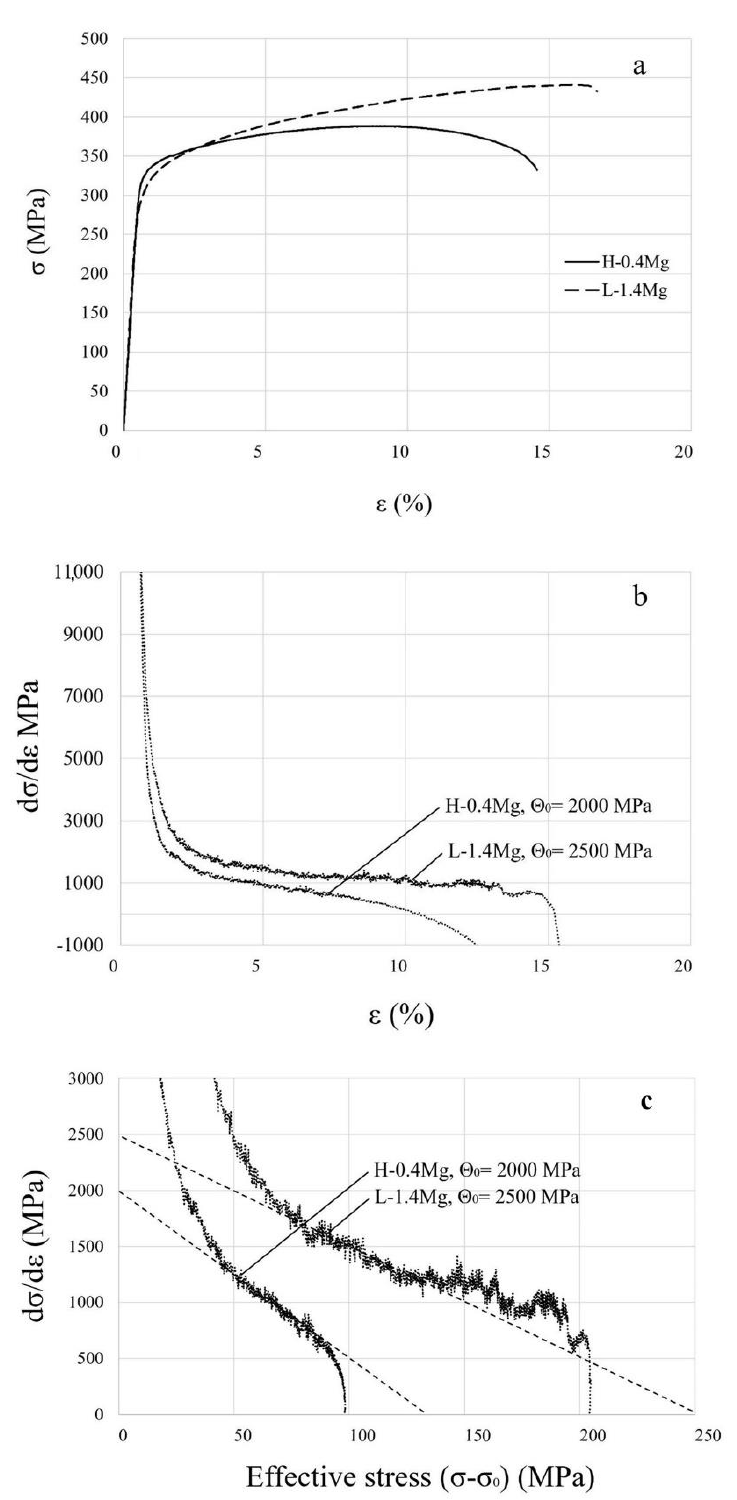
Figure 6. ( a ) True stress–strain curves; ( b ) dependence of strain hardening rate on the strain; ( c ) dependence of the strain hardening rate on the ( σ - σ o ) of H-0.4Mg and L-1.4Mg alloys at peak-aged state.